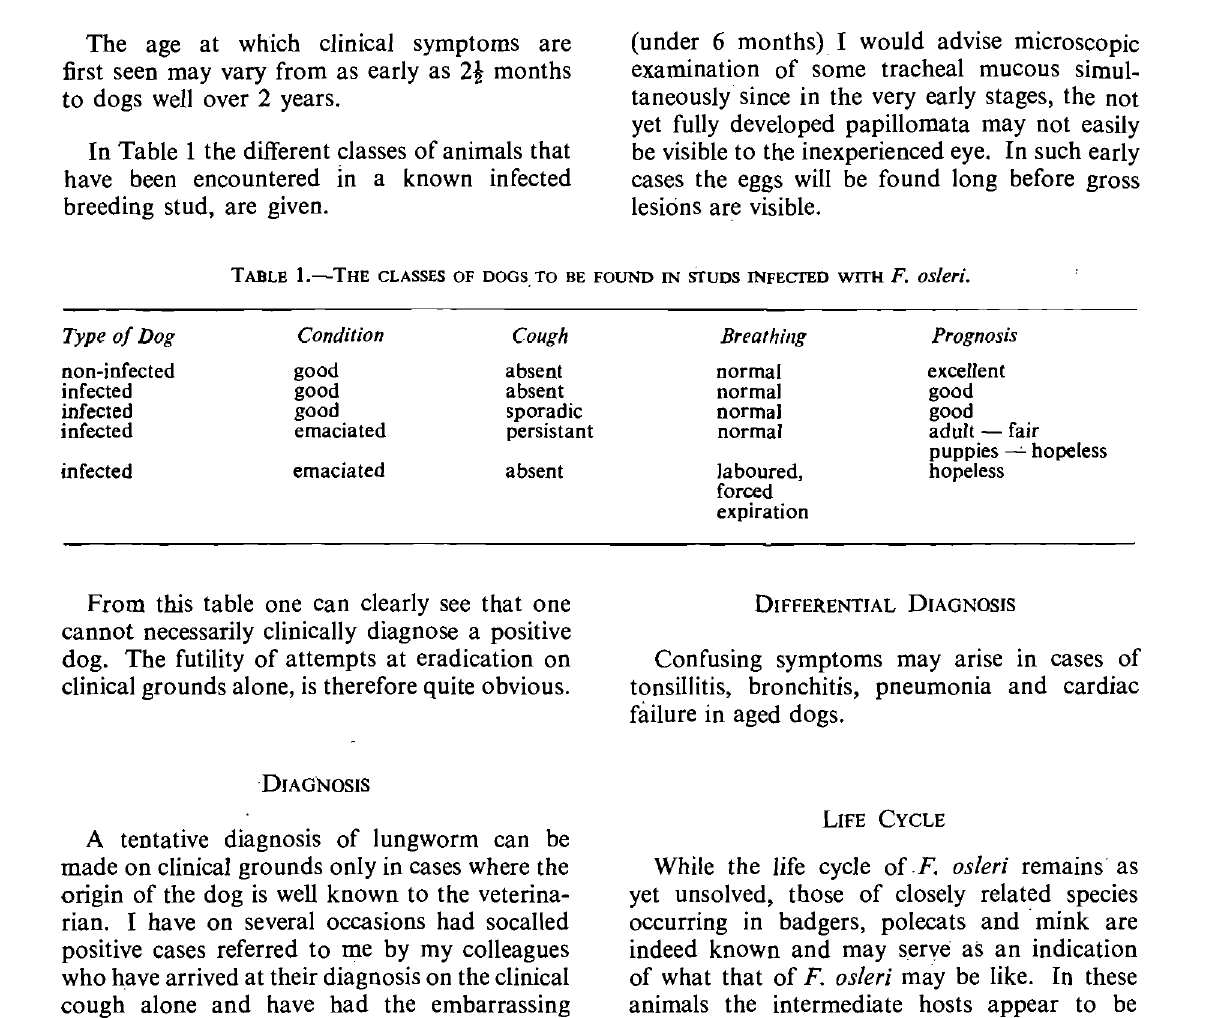
TABLE I.-THE CLASSES OF DOGS TO BE FOUND IN STUDS INFECTED WITH F.